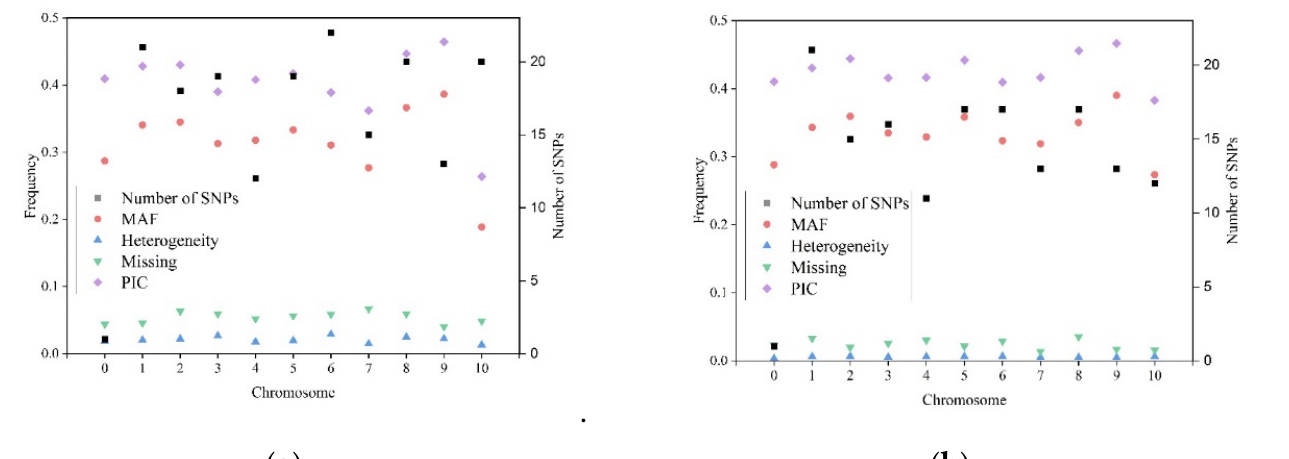
Figure 2. Summary of the heterogeneity, minor allele frequency (MAF), missing rate, and polymorphic information content (PIC) of ( a ) 180 SNPs across 1200 samples and ( b ) 152 high-quality SNPs across 603 CMLs. Chromosome assignments are indicated; where position anchored on non-chromosome, the chromosome is designated as “0”; The heterogeneity, MAF, percentage of Missing value, PIC was shown in left y -axis, the number of SNPs for each chromosome was shown in right y -axis. The genes associated with the KASP markers were used to perform GO